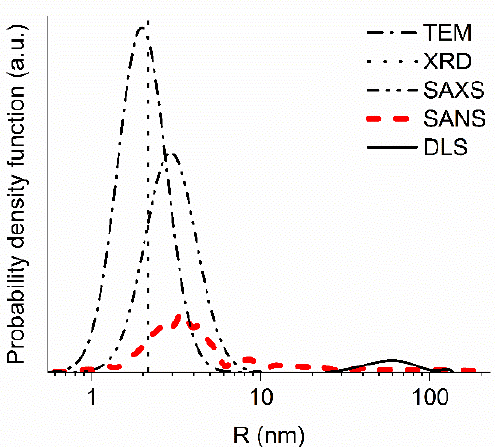
Figure 2. The probability density as a function of radius (nm) evaluated using neutron small-angle scattering (SANS) (red thick dashed line), X-ray small-angle scattering (SAXS) (black thin dash-double-dotted line), TEM (black thin dash-dotted line), and dynamic light scattering (DLS) (black thin solid line). The vertical black dotted line indicates a mean radius measured with XRD. All measurements are performed with F-DND samples, except for SAXS, which is performed with a DND sample. The details of the different measurements are given below in the text.